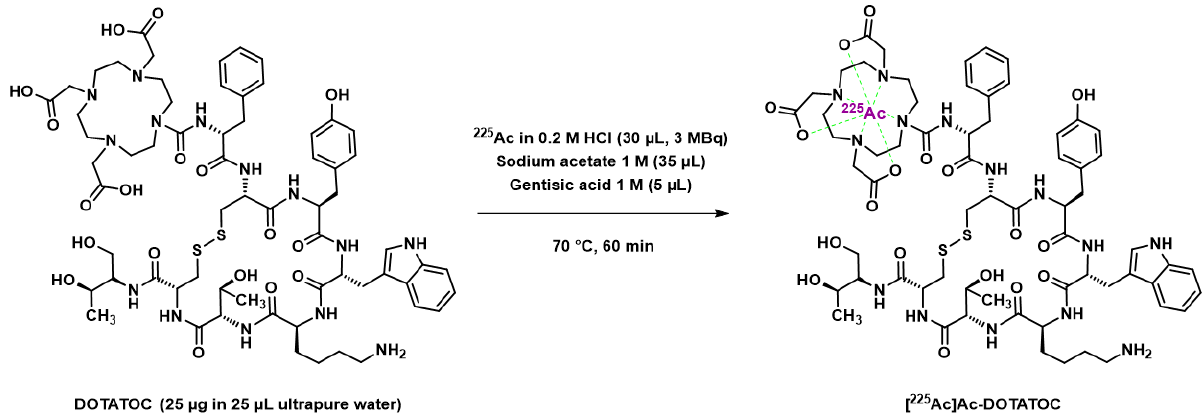
Figure 7. Radiolabeling reaction of DOTATATE with 225 Ac according to Miederer et al. [198]. Activities between 10 and 60 kBq were well-tolerated by the mice; however, activities over 30 kBq induced pathologic changes in the renal cortex, suggesting radiation-induced acute tubular necrosis in both the distal and proximal tubules. Similar results were ob- tained in another study on Sprague Dawley rats that received 111 or 370 kBq [ 225 Ac]Ac– DOTATOC and developed renal tubular nephrosis or renal glomerulopathy [199]. Only a slight accumulation in the liver was objectified, probably due to the release of free 225 Ac. After a single administration of the highest non-toxic activity (20 kBq), tumor weights 14 days after treatment were lower with [ 225 Ac]Ac–DOTATOC than with [ 177 Lu]Lu–DO- TATOC (1 MBq), in accordance with previous studies investigating [ 213 Bi]Bi–DOTATOC [74,75]. This work therefore demonstrated the preclinical value of 225 Ac-radiolabeled oc- treotide derivatives; nevertheless, some questions remained to be answered, such as their potential for chronic toxicity. This point was addressed by Tafreshi et al. through a [ 225 Ac]Ac–DOTATATE toxicity evaluation in BALB/c mice and an efficacy study in SCID mice bearing NCI-H69 or NCI- H727 (human small-cell and non-small-cell lung cancer, respectively) xenografts [200]. In- terestingly, the reaction pH during radiolabeling was controlled with TRIS buffer, em- ployed only for the 225 Ac radiolabeling of other scarce compounds, either DOTA-conju- gated antibodies [201] or peptides [166,173]. L-ascorbic acid was also preferred over gen- tisic acid. After a single injection of 55.5, 111 or 185 kBq in healthy mice, a 5-month follow- up highlighted a weight loss at ~100 days post-injection (p.i.) and a chronic progressive